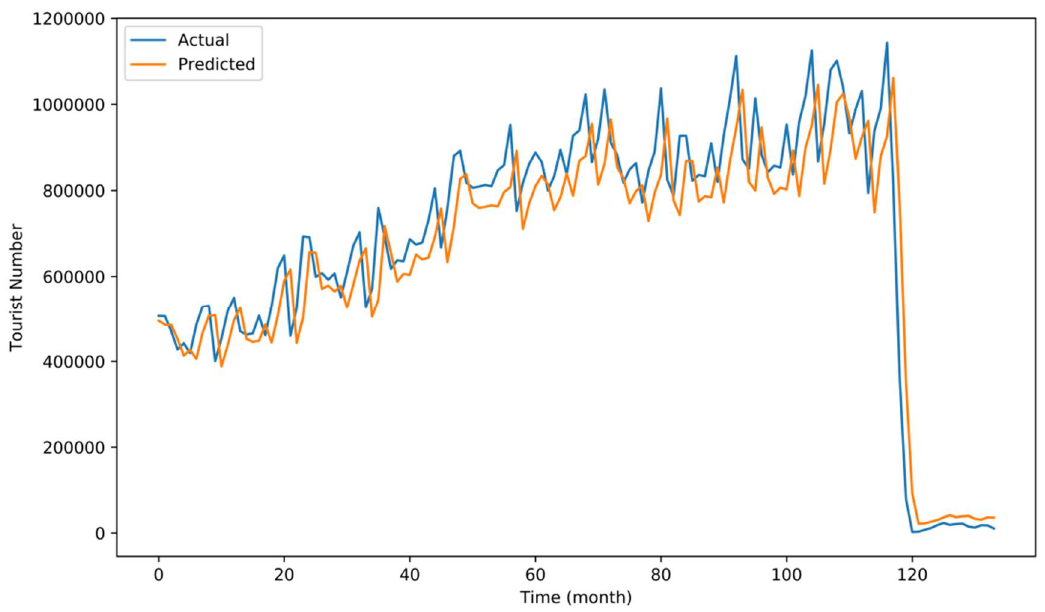
Figure 10. Actual data vs. prediction for GRU.